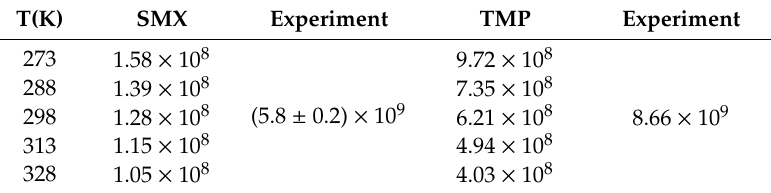
Table 1. Calculated overall rate constants (M − 1 s − 1 ) between 273 and 328 K in the reaction of SMX and TMP with • OH. TMP with •OH. T(K) SMX